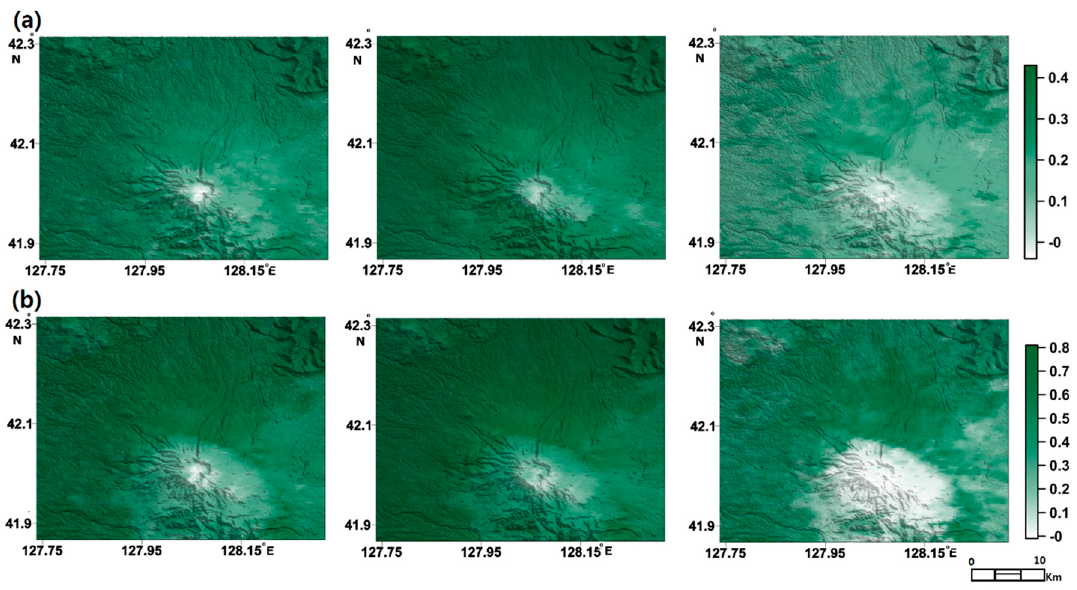
Figure 6. NDVI ( a ) and EVI ( b ) map over Mt. Baekdu target area from MODIS land products in HH1 period ( left ), HH2 ( middle ) and HH3 ( right ). Sensors 2019 , 19 , x FOR PEER REVIEW 12 of 18